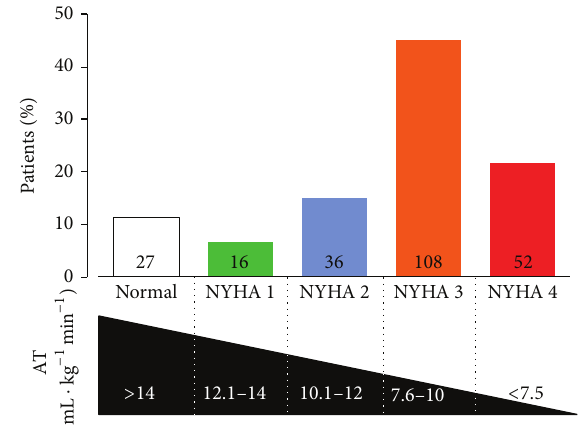
Figure 1: Histogram showing numbers of patients ( 𝑛 = 240 ) stratified by AT-defined NYHA class. Cutoff values for AT estimated from recent published series [25,